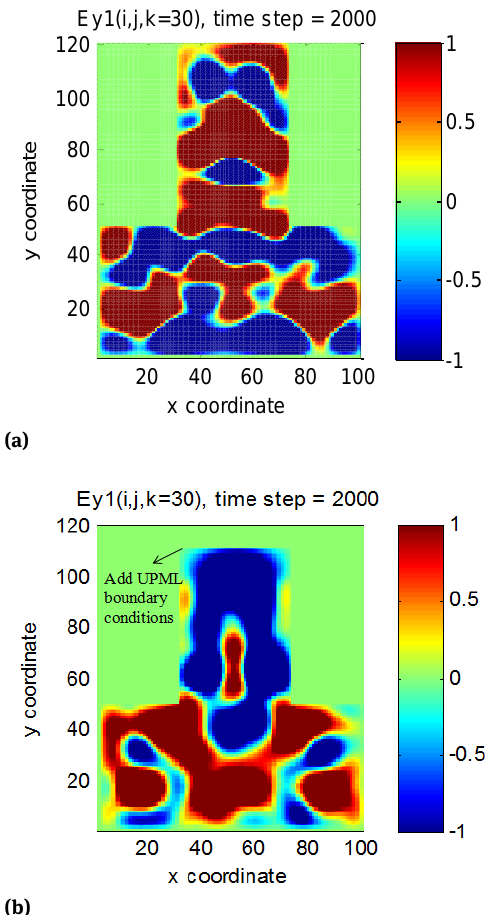
Figure 4: (a) No UPML boundary conditions (b) Add UPML boundary